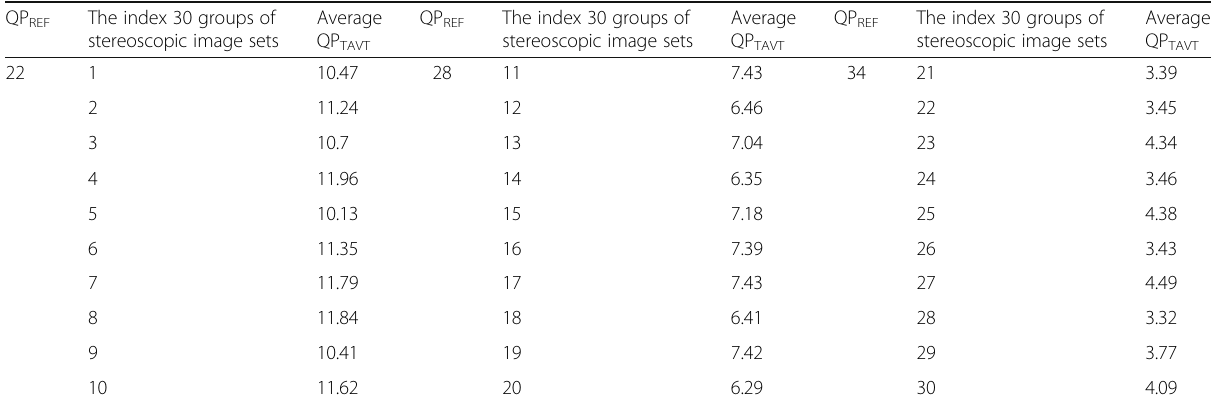
Table 8 Average QP TAVT of each group stereoscopic image set QP REF The index 30 groups of stereoscopic image sets